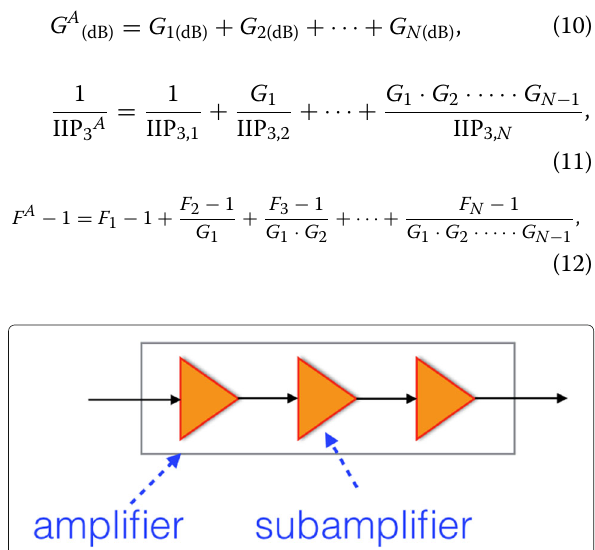
Fig. 5 Three sub-amplifiers in an amplifier- In our example, two MSBs of three sub-amplifiers are allowed to be reconfigured for a screening design